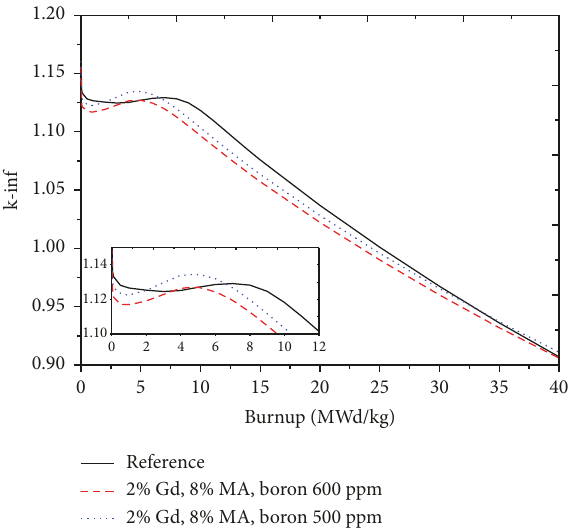
Figure 7: The k-inf versus burnup when loading 6 wt.% of MAs and reducing GD to